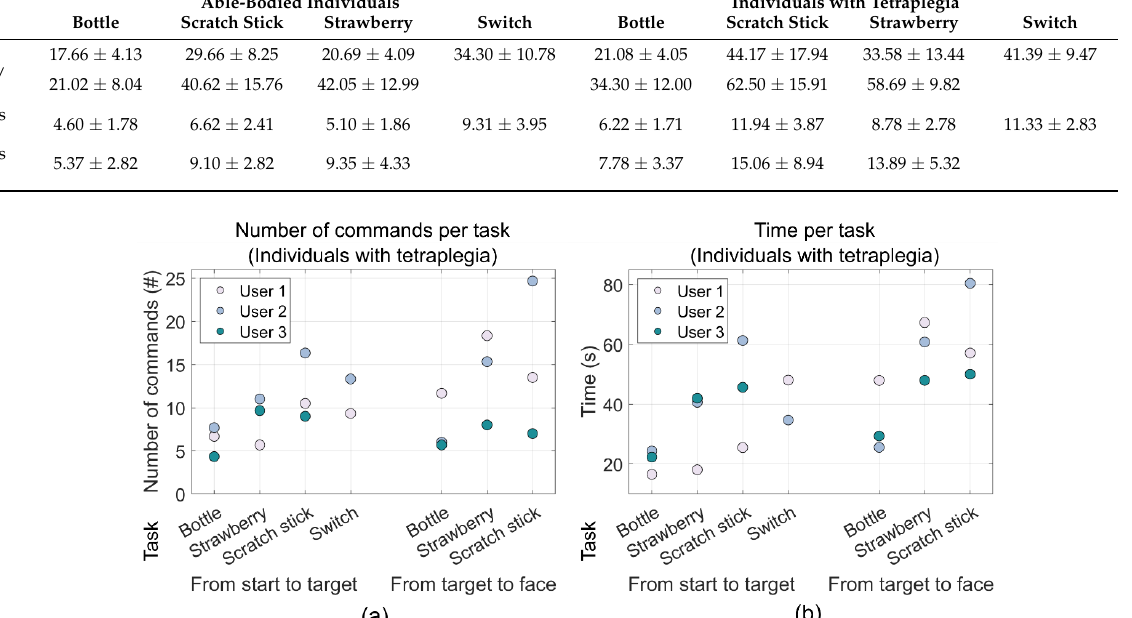
Figure 9. Scatter plots of the mean performance metrics for the individuals with tetraplegia (the users). The two groupings in each plot show the results from the reaching phase and the moving object phase, respectively, and each column corresponds to each task: bottle, strawberry, scratch stick, and switch, respectively. ( a ) Shows the number of commands used during each phase of each task while ( b ) shows the time it took to complete each phase of each task. The data for the switch task for one of the users (user 3) was unfortunately lost.